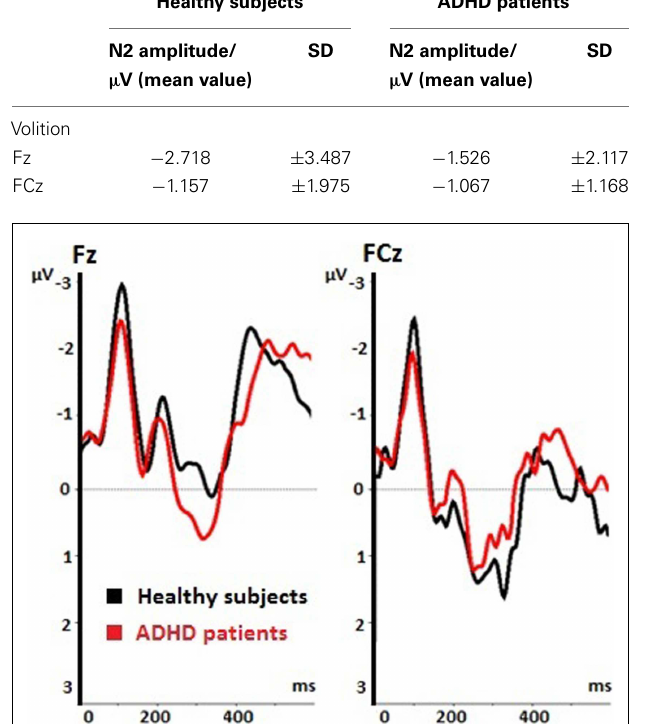
Table 1 | N2 amplitudes during voluntary selection measured at different central electrodes.